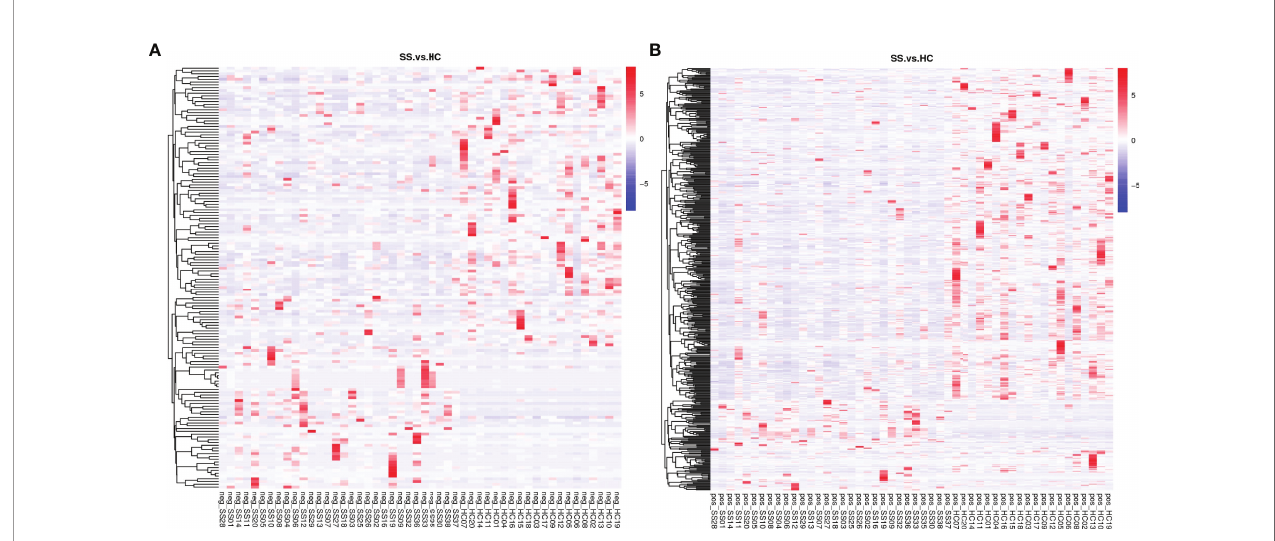
FIGURE 5 | Heat map of the differential metabolites in pSS patients and HCs. (A) ESI-, (B) ESI+. The colors from blue to red indicate the relative contents of the metabolites in the two